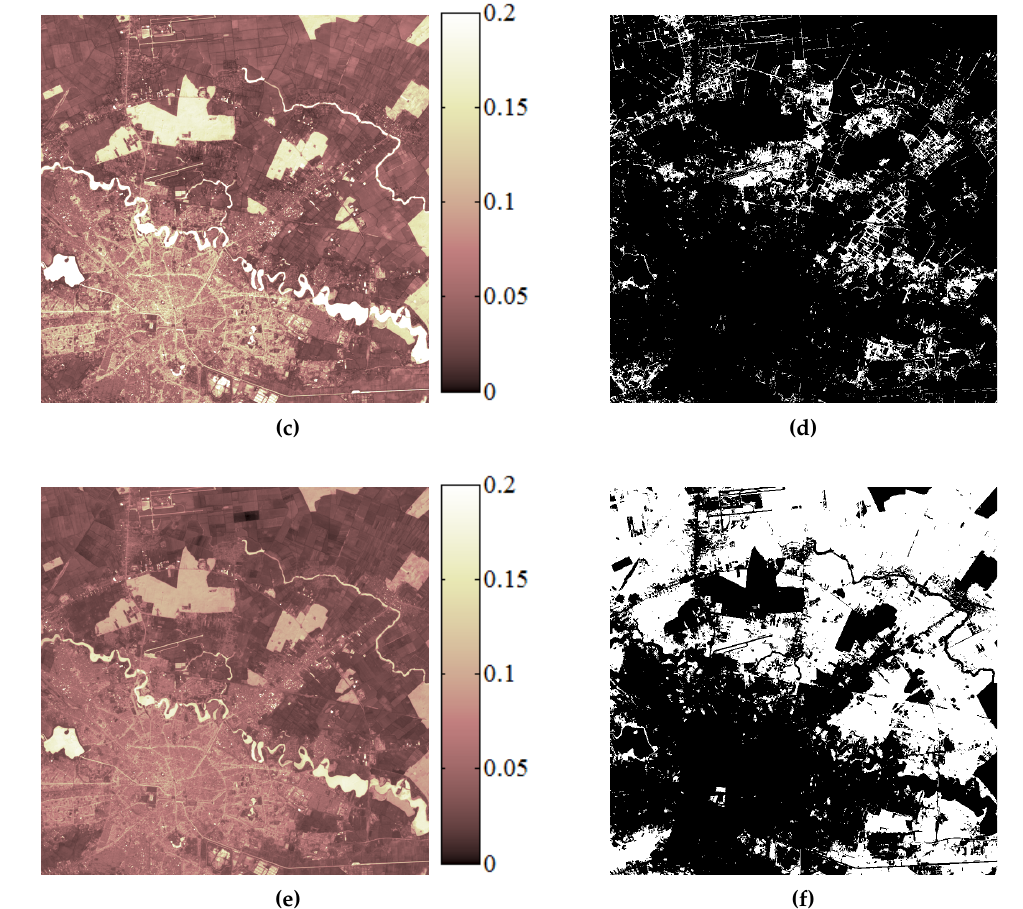
Figure 12. Land use mapping in long Landsat SITS. ( a ) DTW distance image for a query made in the urban area. ( b ) Urban area delimitation using the proposed query-by-example retrieval method. ( c ) DTW distance image for a query made in the extra-urban area. ( d ) Extra-urban area delimitation using the proposed query-by-example retrieval method. ( d ) DTW distance image for a query made inside the agricultural area. ( e ) Agricultural area delimitation using the proposed query-by-example retrieval method. In the case of DTW distance images presented in ( a , c , e ), dark color represents similar evolutions and bright color represents non-similar evolutions, whereas in ( b , d , f ), white pixels correspond to spatio-temporal patterns that are similar to the query, which was selected from the region of